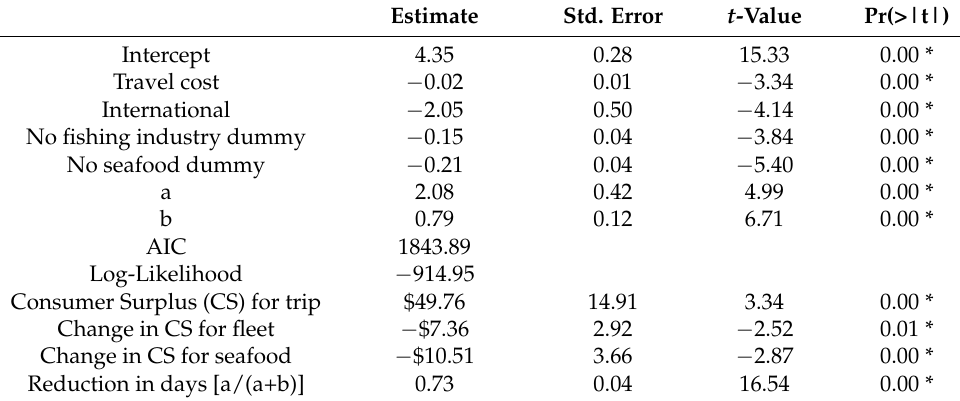
Table 2. Contingent behavior travel cost